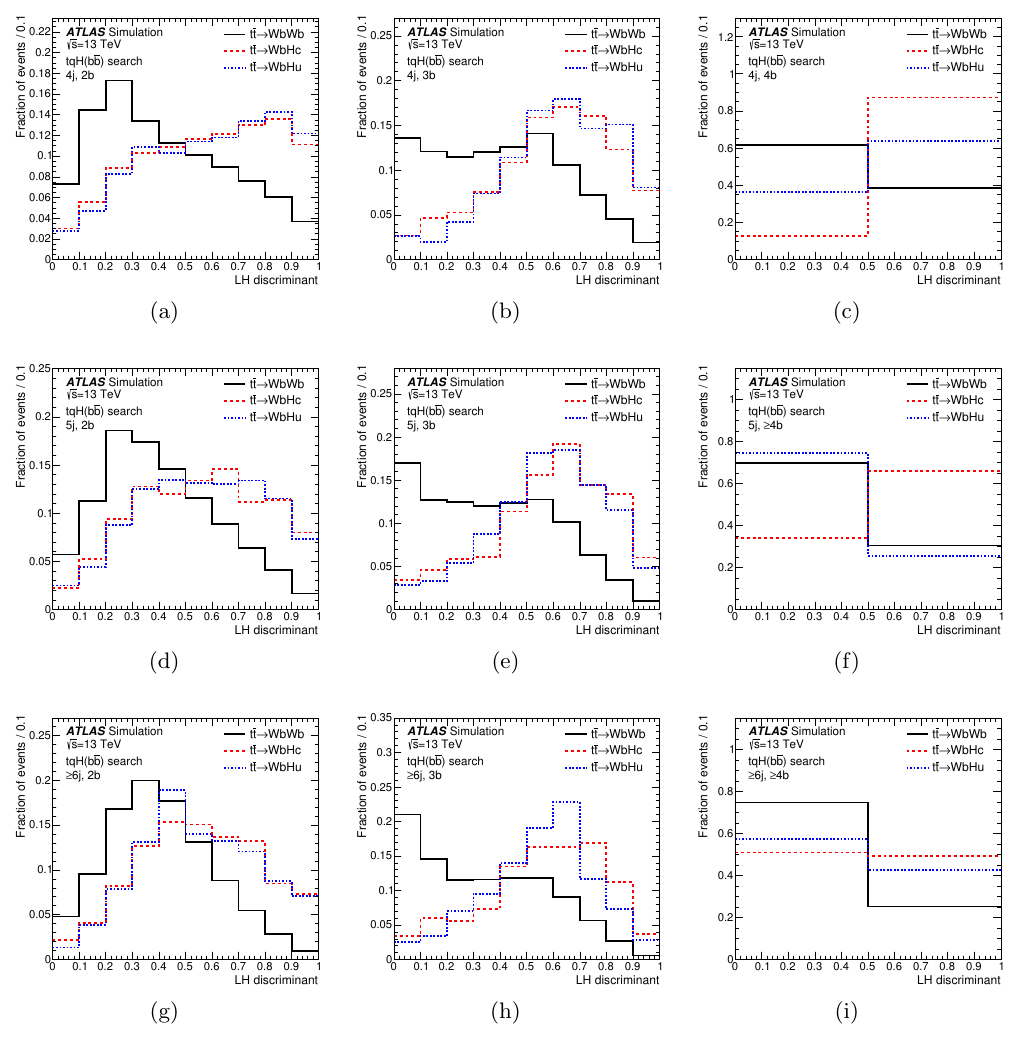
Figure 3 . tqH ( b (cid:22) b ) search: comparison of the distributions of the LH discriminant after preselection of the t (cid:22) t ! WbHc (red dashed) and t (cid:22) t ! WbHu (blue dotted) signals, and the t (cid:22) t ! WbWb background (black solid) in di(cid:11)erent regions considered in the analysis: (a) (4j, 2b), (b) (4j, 3b), (c) (4j, 4b), (d) (5j, 2b), (e) (5j, 3b), (f) (5j, (cid:21) 4b), (g) ( (cid:21) 6j, 2b), (h) ( (cid:21) 6j, 3b), and (i) ( (cid:21) 6j, (cid:21) 4b). In the regions with (cid:21) 4 b -tagged jets, the signal acceptance is small, which translates into a small number of events for the simulated samples. Therefore, only two bins are used for these